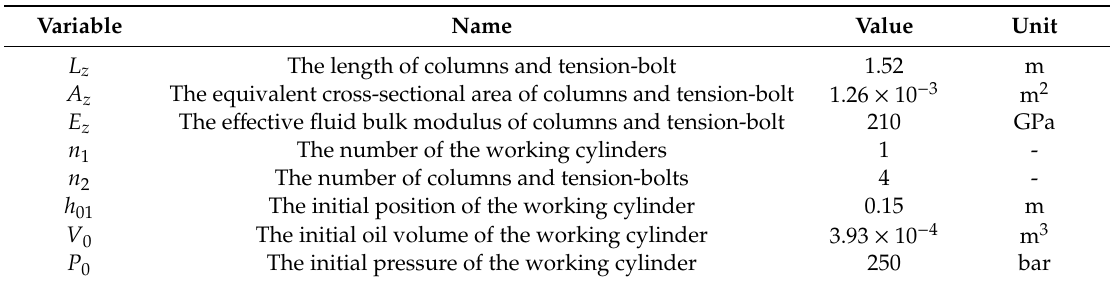
Table 1. Energy storage state parameters of the 0.6 MN forging press test-bed before the pressure relief under a certain